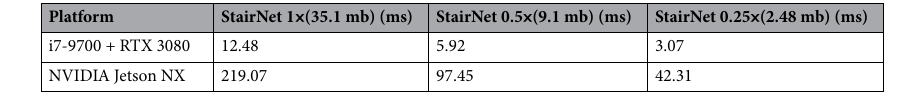
Table 3. Results of the model inference speed experiments.